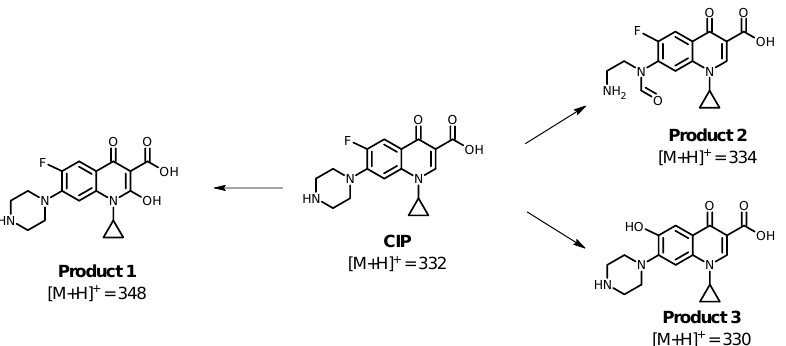
Figure 7. Primary transformation products for CIP under the action of ultrasound process alone. The mass spectra of CIP and its primary transformation products are presented in Figures S5 – S8.